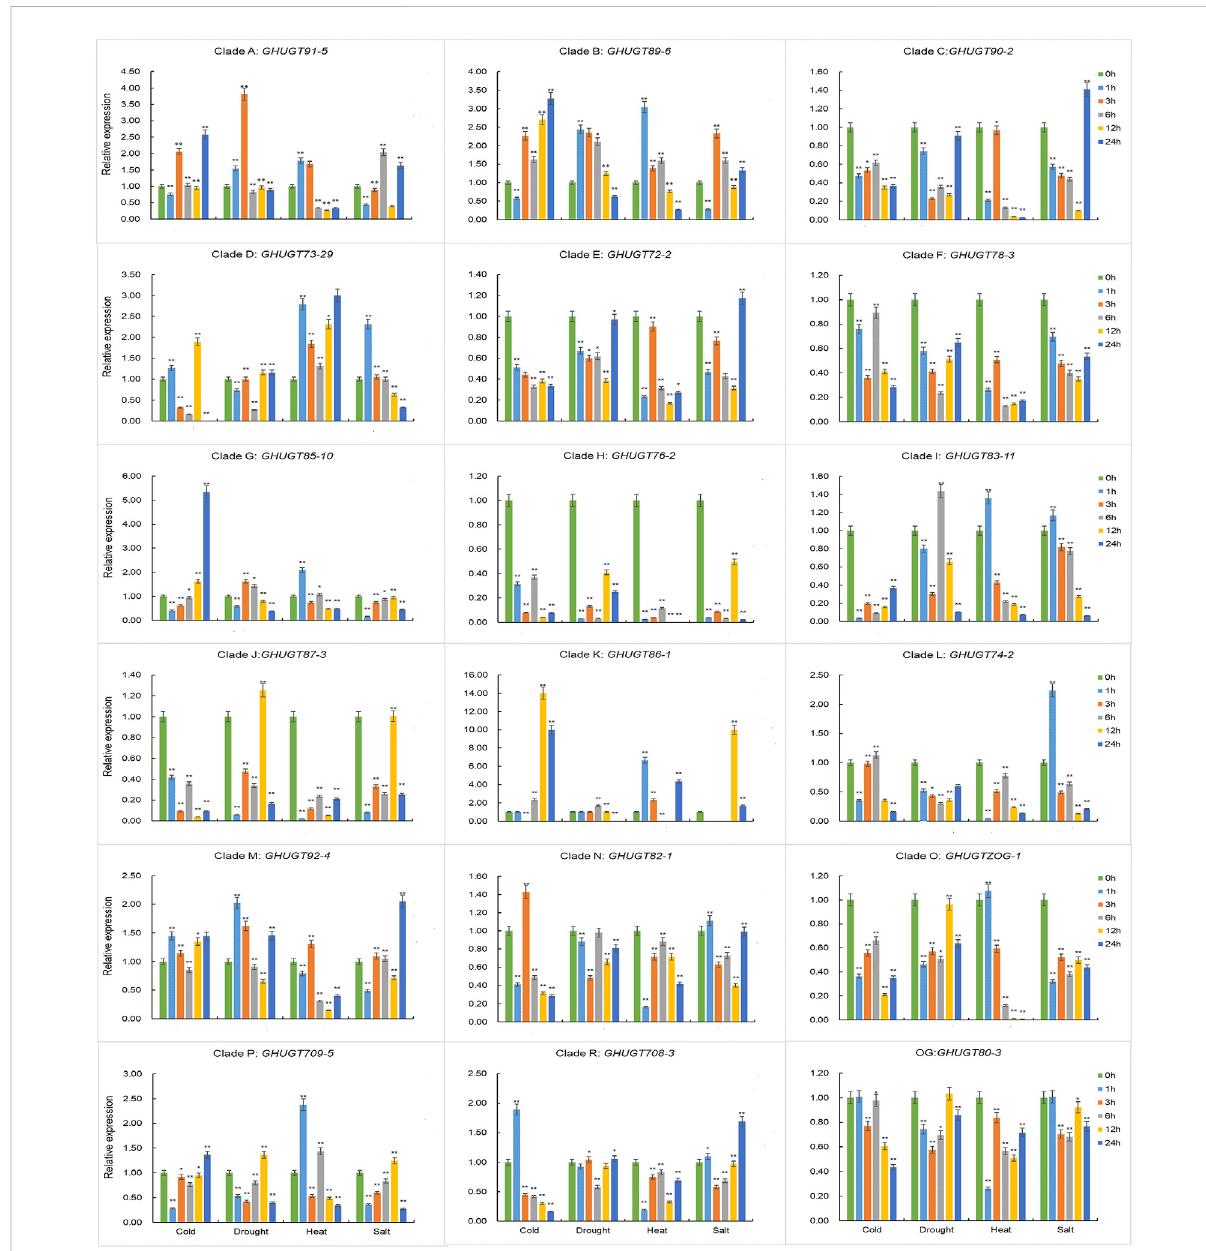
FIGURE 12 The expression levels of 18 GHUGT members at different times under abiotic stresses, including cold, drought, heat and salt. Error bars represent the SD between three biological replicates in each treatment group. The statistical test is Student ’ s t-test. *: p < 0.05, **: p <